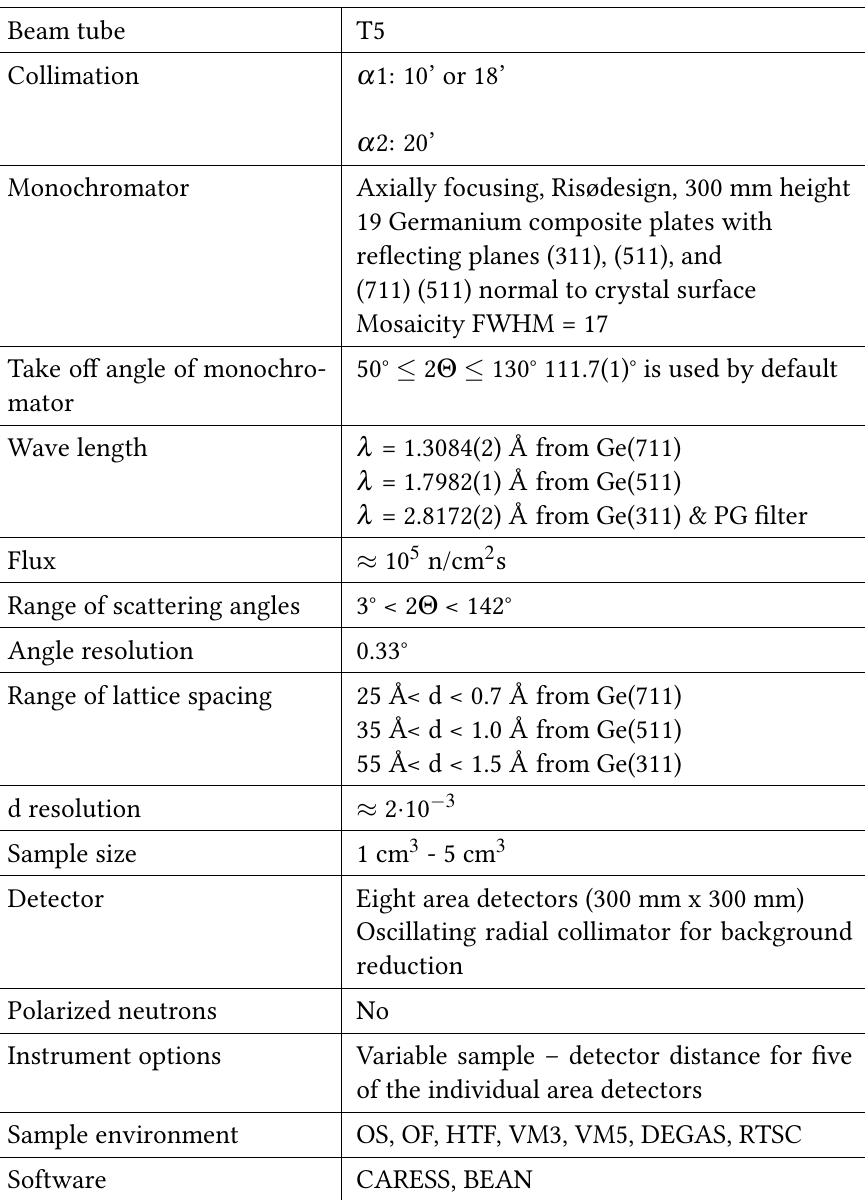
Table 1: Technical parameters of